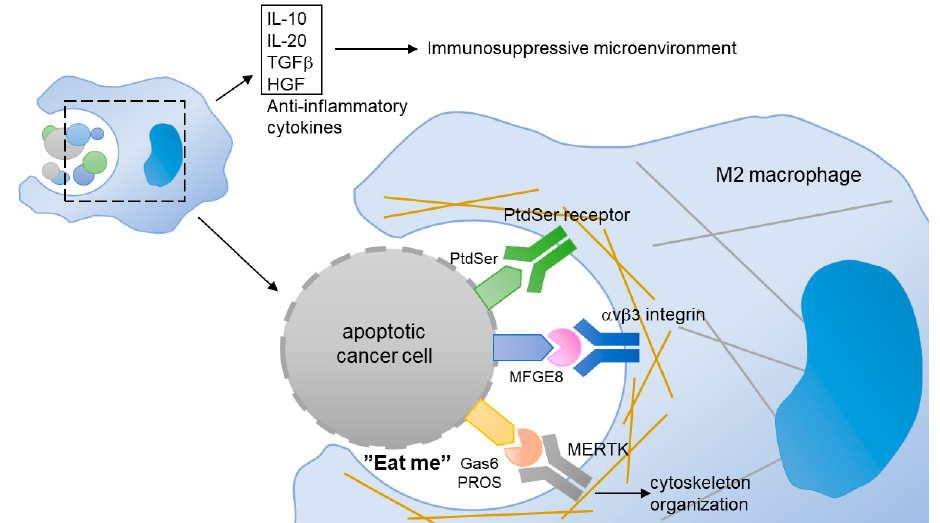
Figure 7. In tumor, M2-like macrophages scavenge the apoptotic cancer cells through a process of efferocytosis. Gas6 or PROS binds to the PtdSer presented on the membrane of apoptotic cells. The MERTK expressed in M2-like macrophages interacts with the Gas6/PtdSer complex, and induces cytoskeleton reorganization. In addition, MERTK expressed in macrophage can contribute to the release of anti-inflammatory cytokines that build an immunosuppressive